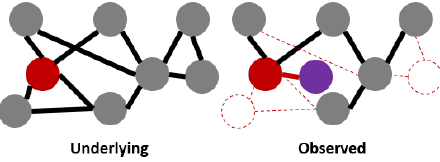
Figure 1. Example: network analysis of an observed network. The adversarial actions on the target node (red) are: adding a new node not present in the underlying network (e.g., creating a fake account), hiding ties to other nodes (e.g., unfriending accounts), and preventing two nodes from being observed (e.g., getting other accounts deactivated or deleted). Refer to Figure 2 for